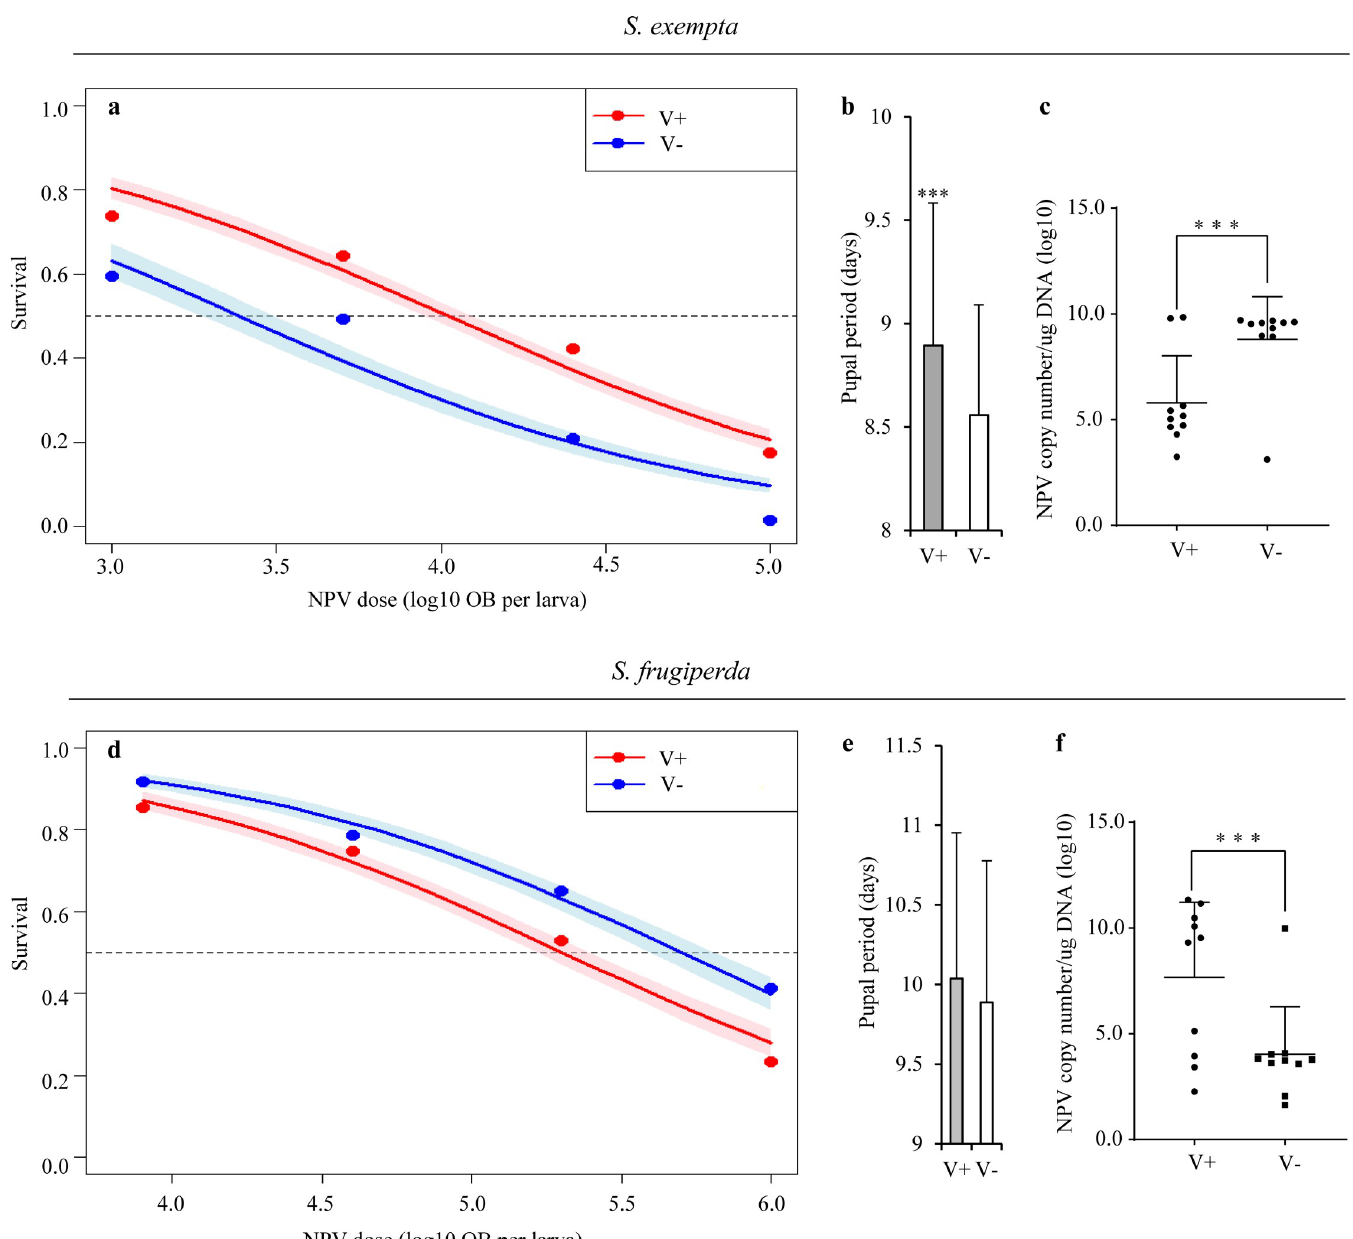
Fig 4. Relationship between the baculoviruses (SpexNPV and SfMNPV) and the partiti-like viruses in larvae of S . exempta (a-c) and S . frugiperda (d-f). (a,d) Effect of NPV dose (log 10 -transformed number of occlusion bodies per larva) on larval survival to pupation in S . exempta (a) (logistic regression: χ 2 = 25.798, d.f. = 1, P < 0.0001) and S . frugiperda (d) (logistic regression: χ 2 = 9.447, d.f. = 1, P = 0.0022). The points are the raw means for each dose. The thick lines are the fitted values and the shaded zones are the standard errors around these fitted values; blue points, lines and shading are the three partiti-like viruses-negative larvae (V-); red points, lines and shading are the three partiti-like viruses-positive larvae (V+). The numbers of larvae at different concentrations for SpexNPV (0 (control), 1 × 10 3 , 5 × 10 3 , 2.5 × 10 4 , and 1 × 10 5 OBs/larva) were 63, 64, 67, 82, 79 for virus-negative individuals and 96, 109, 134, 133, 127 for virus-negative individuals; for SfMNPV (0 (control), 8 × 10 3 , 4 × 10 4 , 2 × 10 5 , and 1 × 10 6 OBs/larva) they were 92, 85, 104, 149, 87 for virus-negative individuals and 100, 95, 111, 106, 90 for virus-positive individuals. (b,e) The pupal period of survivors of NPV-challenge in S . exempta (b) (linear model: F = 12.263, d.f. = 1,265, P = 0.00054) and S . frugiperda (e) (linear model: F = 2.30, d.f. = 1,413, P = 0.0940). (c, f) NPV copy numbers (log 10 -transformed) at 72 h post-challenge with SpexNPV (c) (F = 10.095, d.f. = 18, P = 0.0052) and SfMNPV (f) (F = 7.504, d.f. = 18, P = 0.0134). The concentrations of NPV were 2.5 × 10 4 OBs/larva and 2 × 10 5 OBs/larva for SpexNPV and SfMNPV respectively. V- = the three partiti-like viruses-negative larvae, V+ = the three partiti-like viruses-positive larvae. Means ± SD. ��� = P < 0.001, based on t-tests at each time-point.